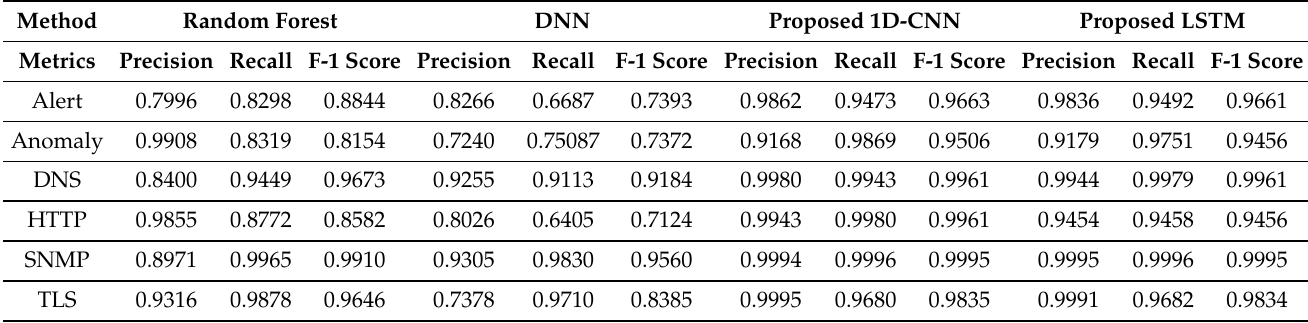
Table 1. Quantitative performance evaluation of the developed LSTM technique in terms of Precision, Recall and F-1 score